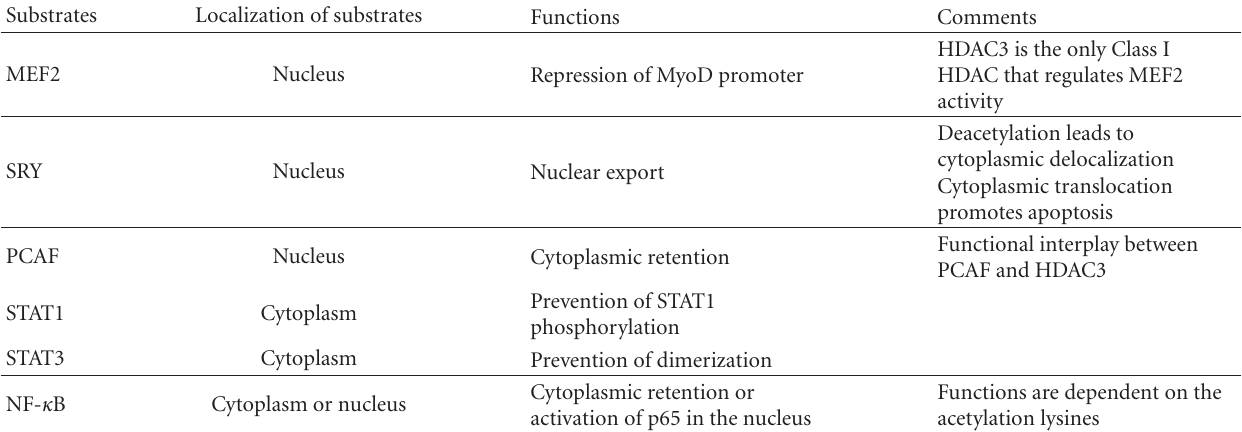
Table 1: Subcellular localization and functions of nonhistone substrates of